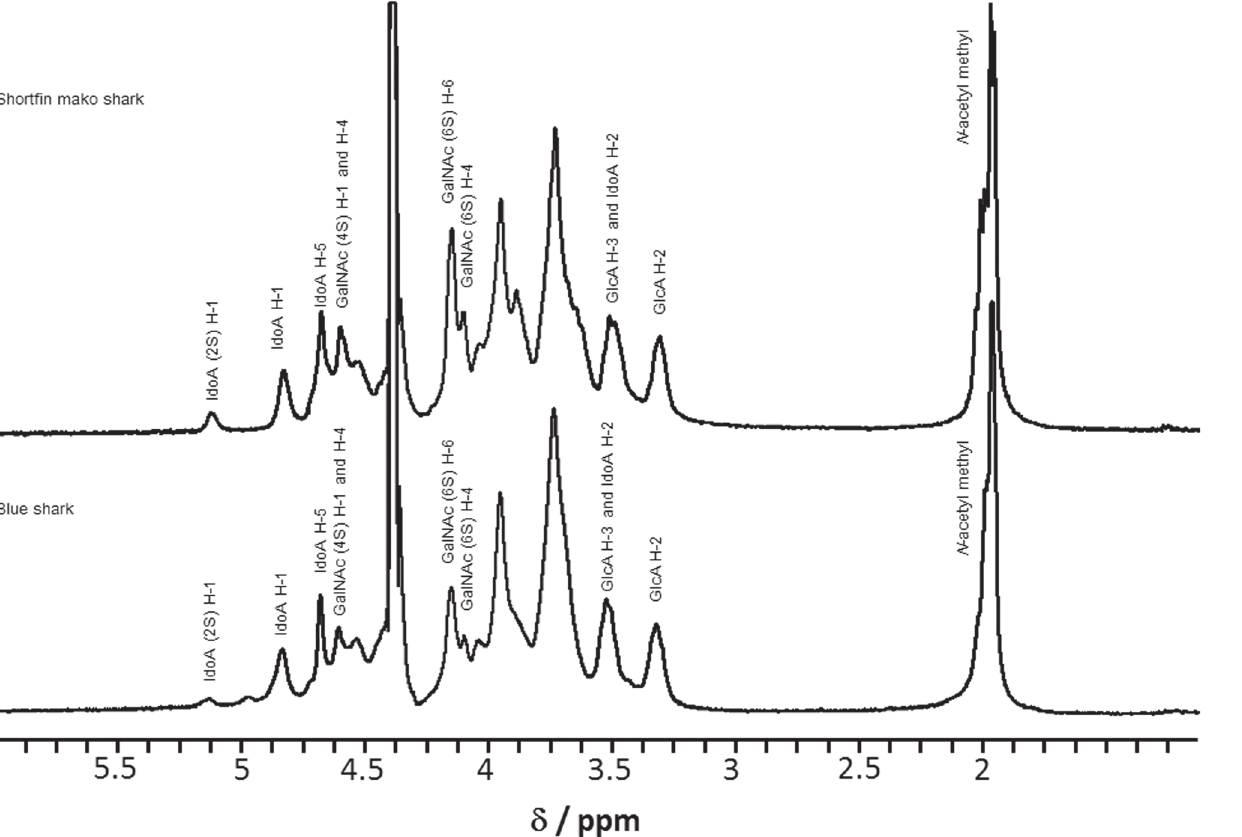
Fig 5. One-dimensional 1 H-NMR spectra of CS/DS from shortfin mako shark (Fr. 5) and blue shark (Fr. 3).